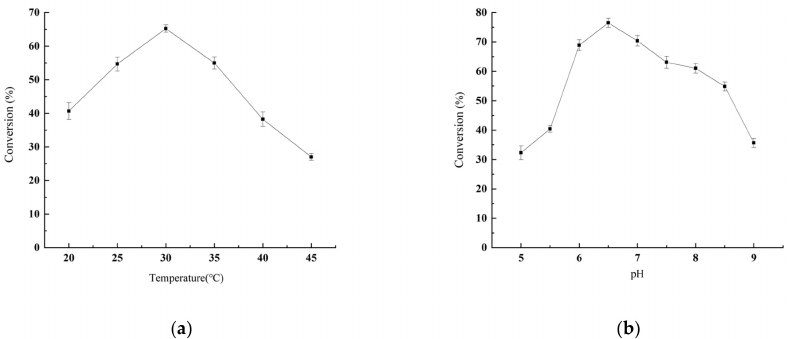
Figure 3. Effect of temperature ( a ) and pH ( b ) on enzymatic double reduction of ( E / Z )-citral to ( S )-citronellol. The reaction mixture (10 mL) contained 200 mM ( E / Z )-citral, 600 mM glucose, 1 g wet cells, 0.2 mM NADP + , 20% ( v/v ) isopropanol and 50 mM buffer. ( a ), the reactions in 50 mM Tris-HCl buffer (pH 8.0) were conducted at 20–45 ◦ C and 200 rpm for 12 h. ( b ), the reactions were conducted at 30 ◦ C, 200 rpm and pH 5–9 for 12 h. Standard deviations are indicated in the diagram ( n = 3).